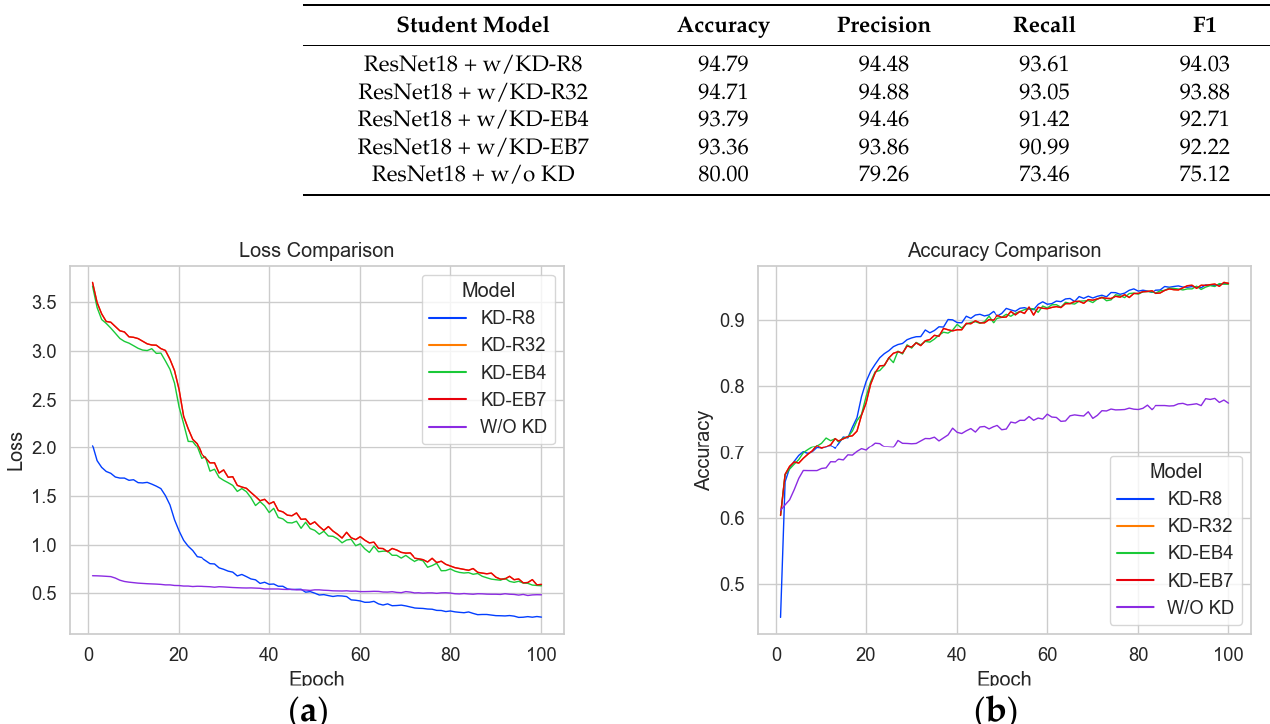
Figure 10. Loss and Accuracy for all student models: ( a ) Loss; ( b ) Accuracy. Table 6. Performance of the student models based on KD. Student Model Accuracy